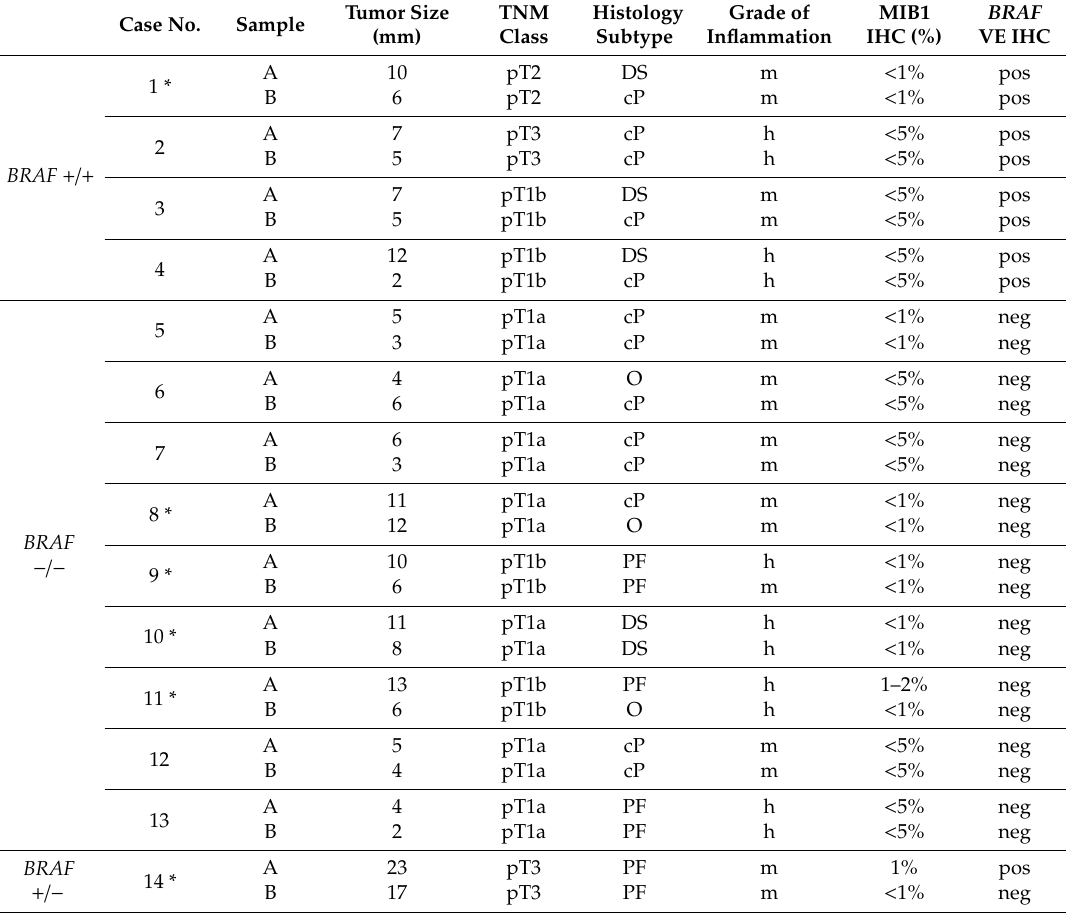
Table 1. Multiple thyroid cancer (TC) tumor foci associated with Hashimoto’s thyroiditis (HT): histology and functional parameters.